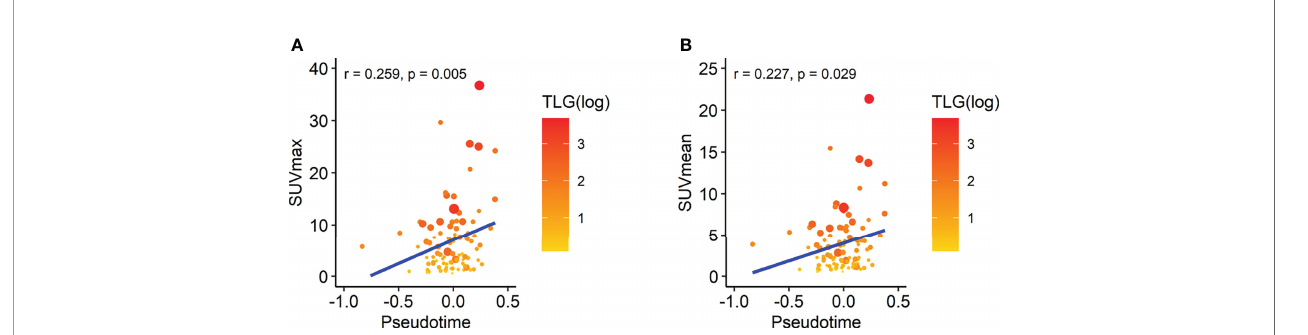
FIGURE 5 | Correlation between SUV and pseudotime in LUAD samples of the NSCLC radiogenomics dataset. The size of the dot represents the metabolic tumor volume. The color of the dot represents total lesion glycolysis as a log scale. (A) The maximal SUV showed a weakly positive correlation with pseudotime (r = 0.259,